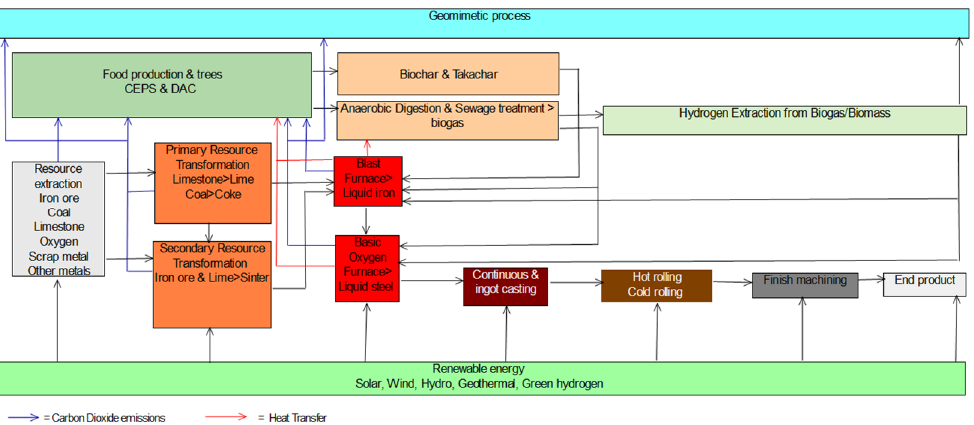
Figure 1. Simul8 steel linear production configuration *. * The colour-coding within Figure 1 is identical to the master database (Excel), which has been created to gather and display findings, facts, and figures, and is supposed to signify the energy intensity and heat development at the different stages of the steelmaking process in